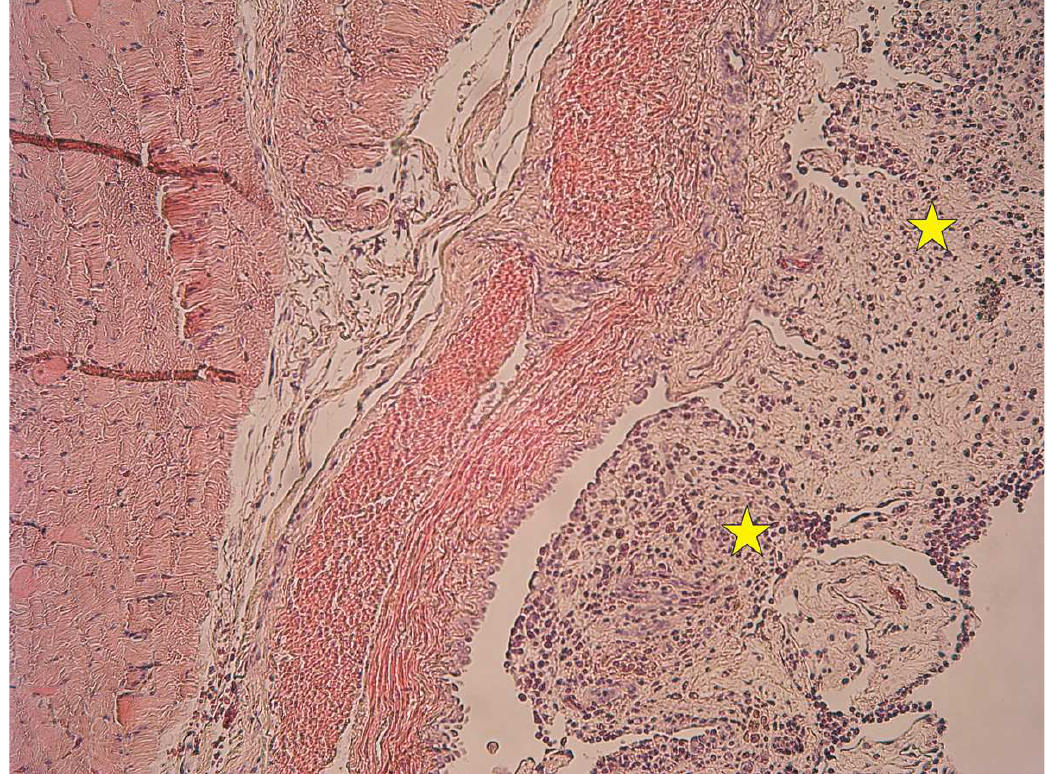
Fig. 5. Chronic granulomatous peritonitis caused by Setaria tundra . Fibrous thickening (stars) of the peritoneum with lymphoplasmacytic and eosinophilic